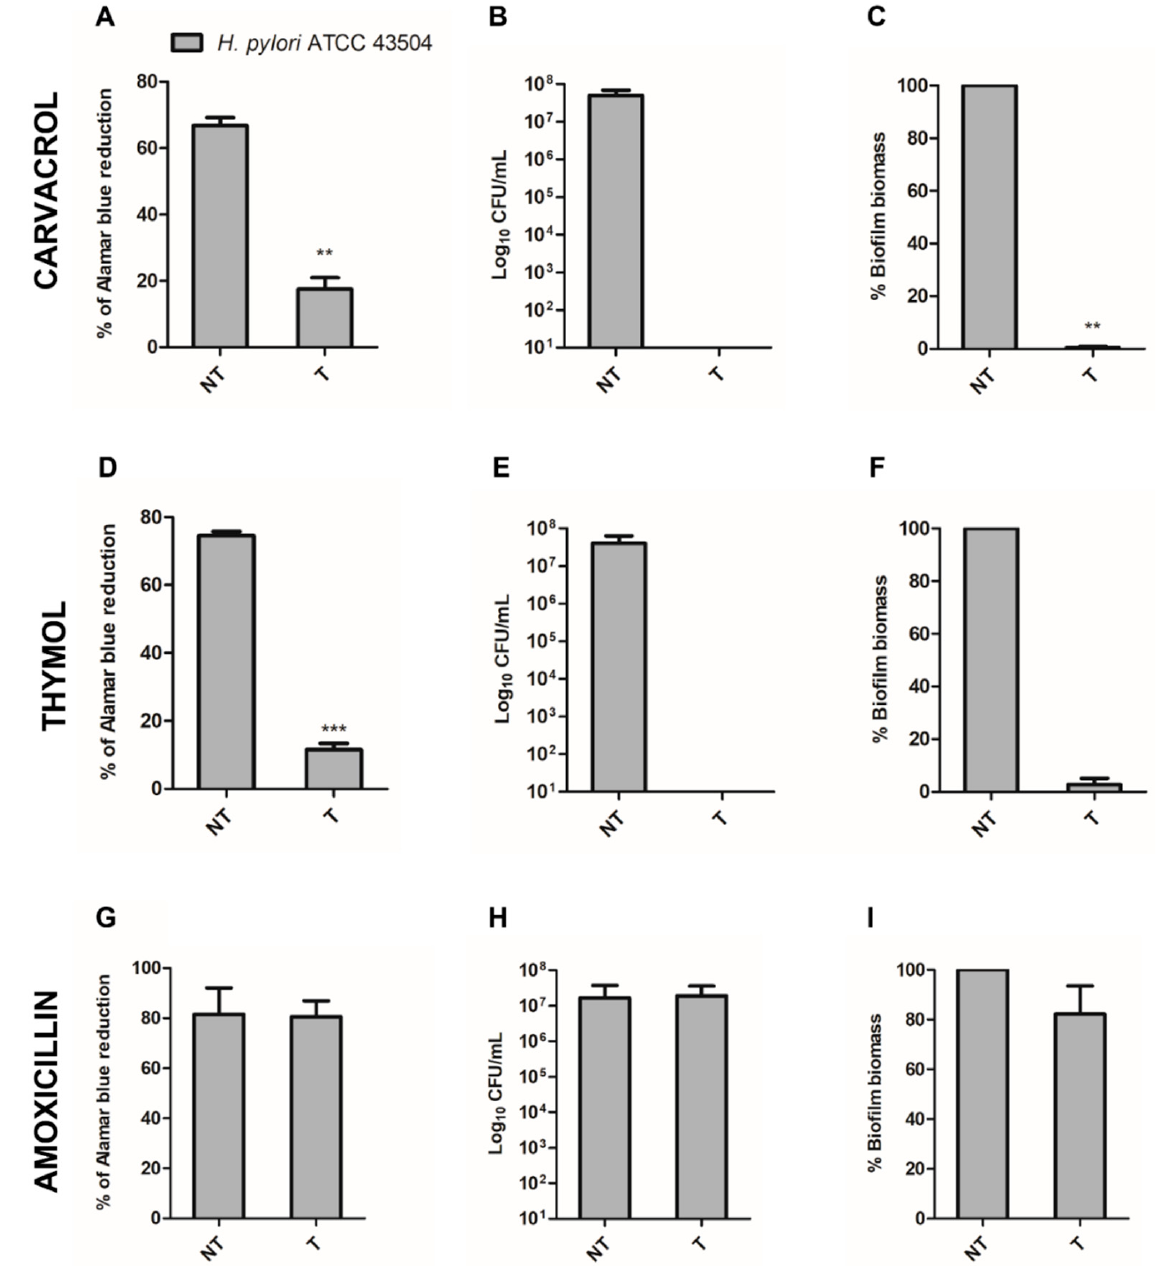
Figure 2. Determination of the MBIC of carvacrol, thymol, and amoxicillin versus H. pylori through the alamarBlue assay ( A , D , G ), the CFU count ( B , E , H ), and the crystal violet assay ( C , F , I ). T: treated samples; NT: non-treated samples. ** p < 0.005, *** p < 0.001 vs. the non-treated sample.